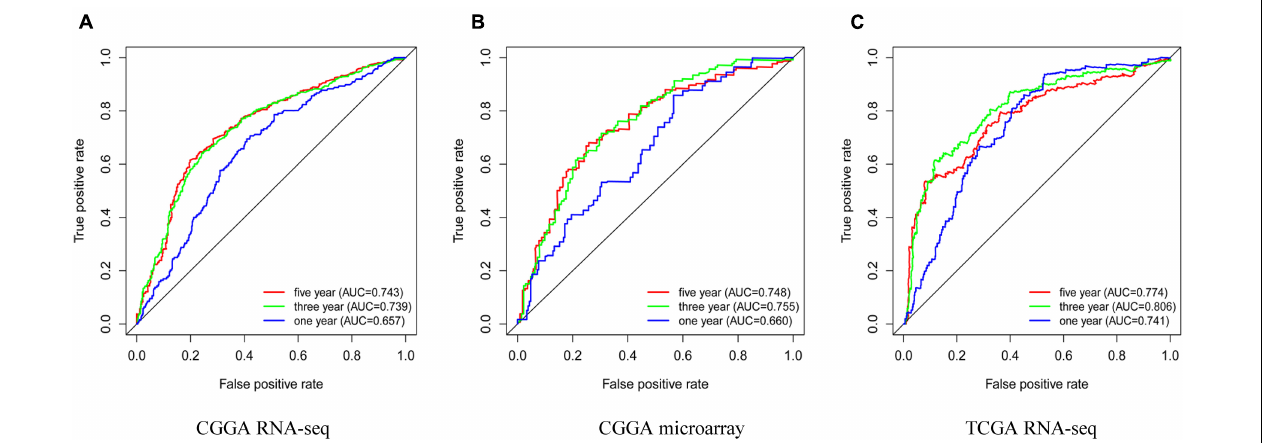
FIGURE 4 | Prognostic factors and risk assessment of glioma and the diagnostic value of ESPL1. (A) The receiver operating characteristic (ROC) curve in CGGA sequence. (B) ROC curve in CGGA microarray. (C) ROC curve in TCGA